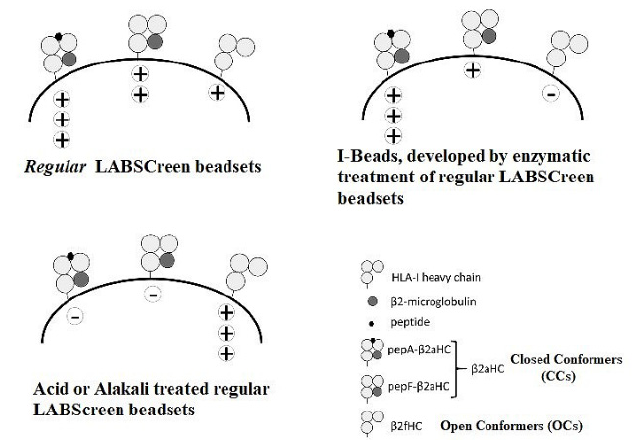
Figure 4. Three different kinds of microbeads used: Regular beads admixed with CCs and OCs; The acid or alkali treated regular beads with OC only, (iii) beads restricted with CC. The microbeads were characterized using W6/32 (IgG2a) bound to peptide-associated and peptide-free CCs, but not bound to the OCs. HC-10 (IgG2a) recognized CCs devoid of a peptide. HLA-I polyreactive mAb TFL-006 (IgG2a) bound to OCs only and was inhibited by the shared peptides ( 117 AYDGKDY 123 and 126 LNEDLRSWTA 135 ) found in all HLA-I isoforms.